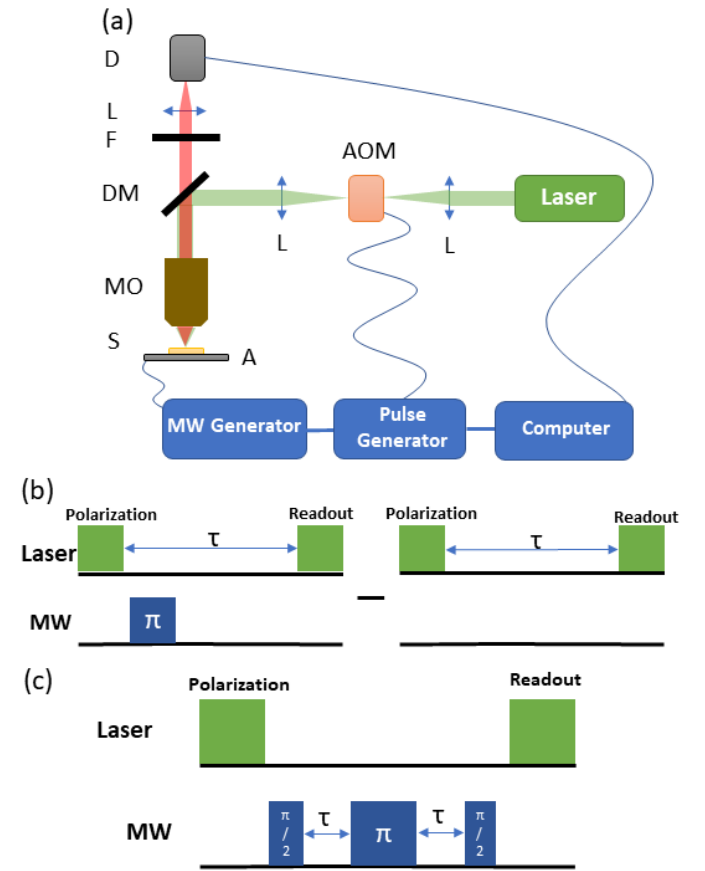
Figure 4. Schematics of the measurement setup: ( a ) the confocal setup, D—detector, L—lens, F—filter, DM—dichroic mirror, MO—microscope objective, S—sample, A—MW antenna, AOM—acusto- optical modulator. The optical and microwave pulse sequence used for T 1 ( b ) and T 2 ( c ) measure- ments. The upper (green) rectangles mark the optical excitation, whereas the lower (blue) ones represent the MW